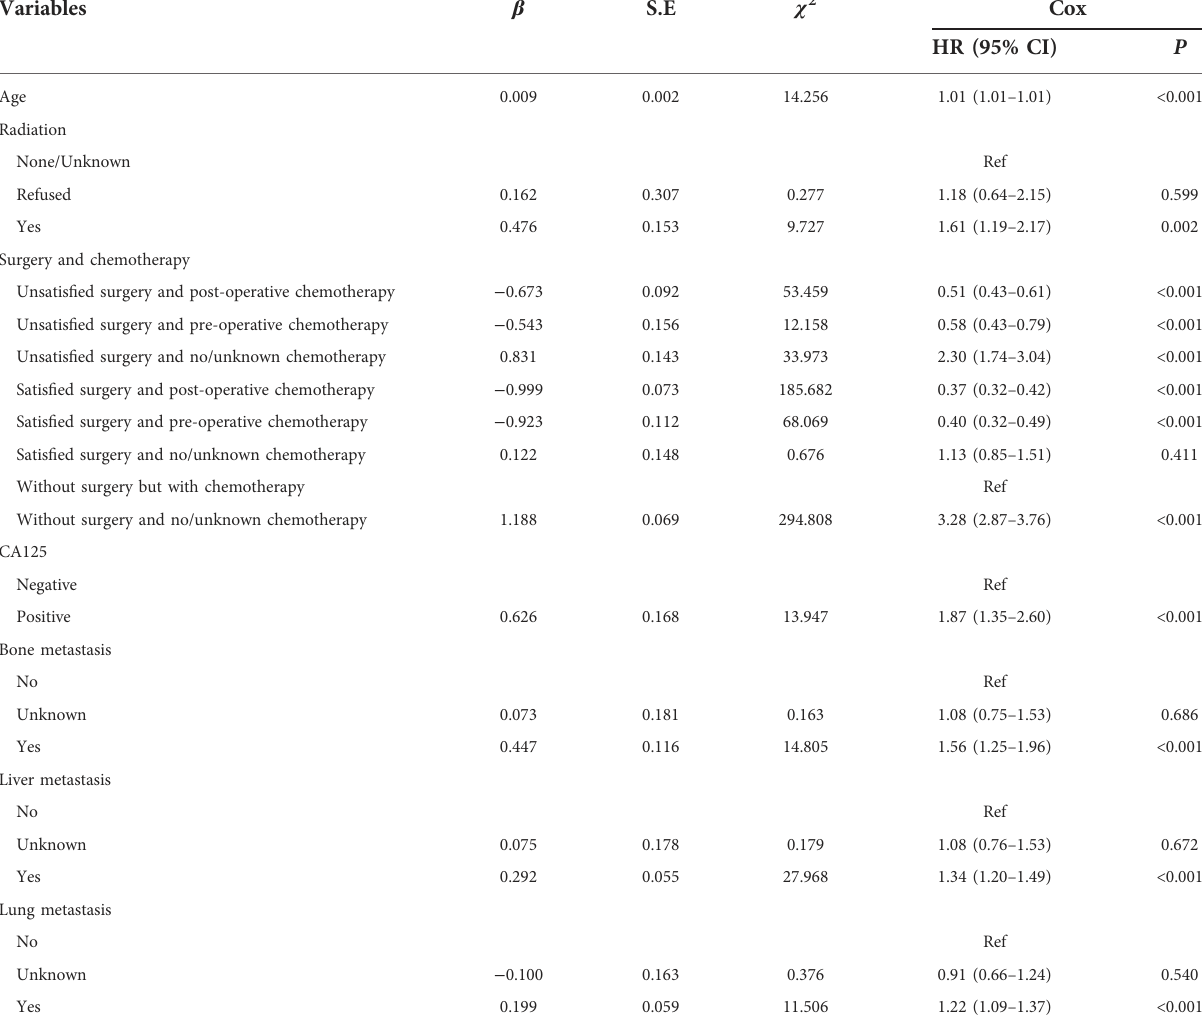
TABLE 4 Multivariable analysis for screening the predictors for 2-year overall survival of metastatic ovarian cancer patients. Variables